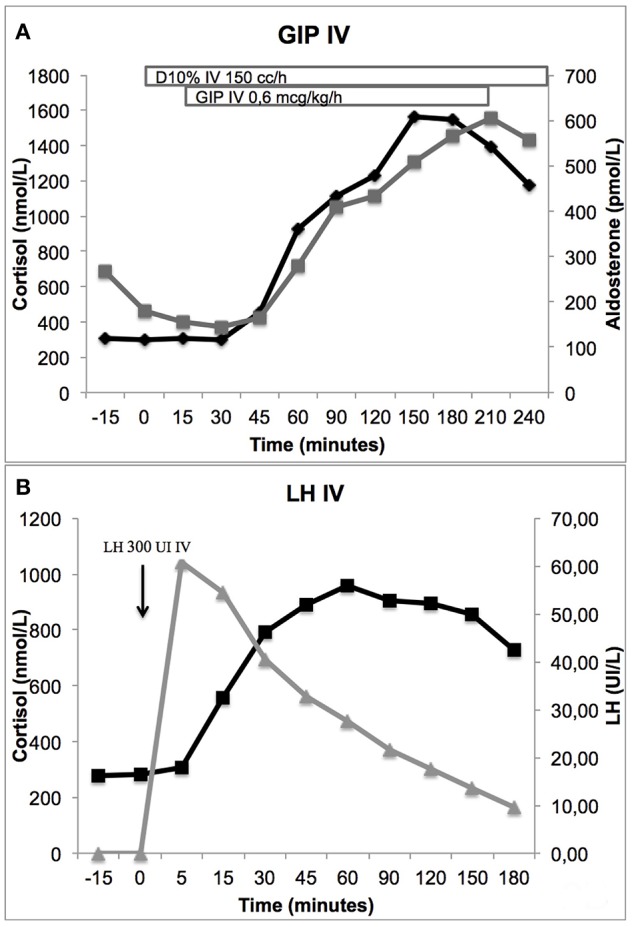
Cortisol response to stimulation by GIP 0.6 mcg/kg/h IV perfusion (416%) (A) and by hLH 300 IU IV (243%) (B). Aldosterone response to GIP stimulation is also shown (169%) (A).